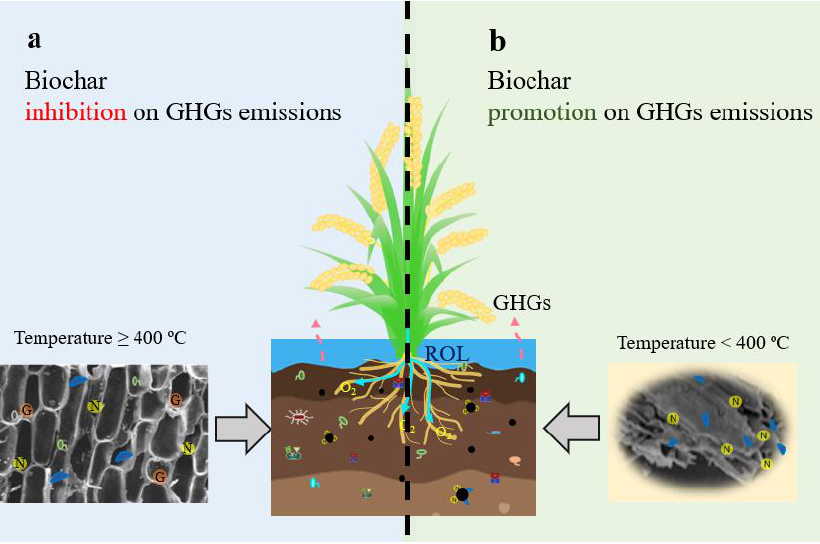
Figure 2. Inhibition ( a ) and promotion ( b ) of greenhouse gas emissions by BCs in rice